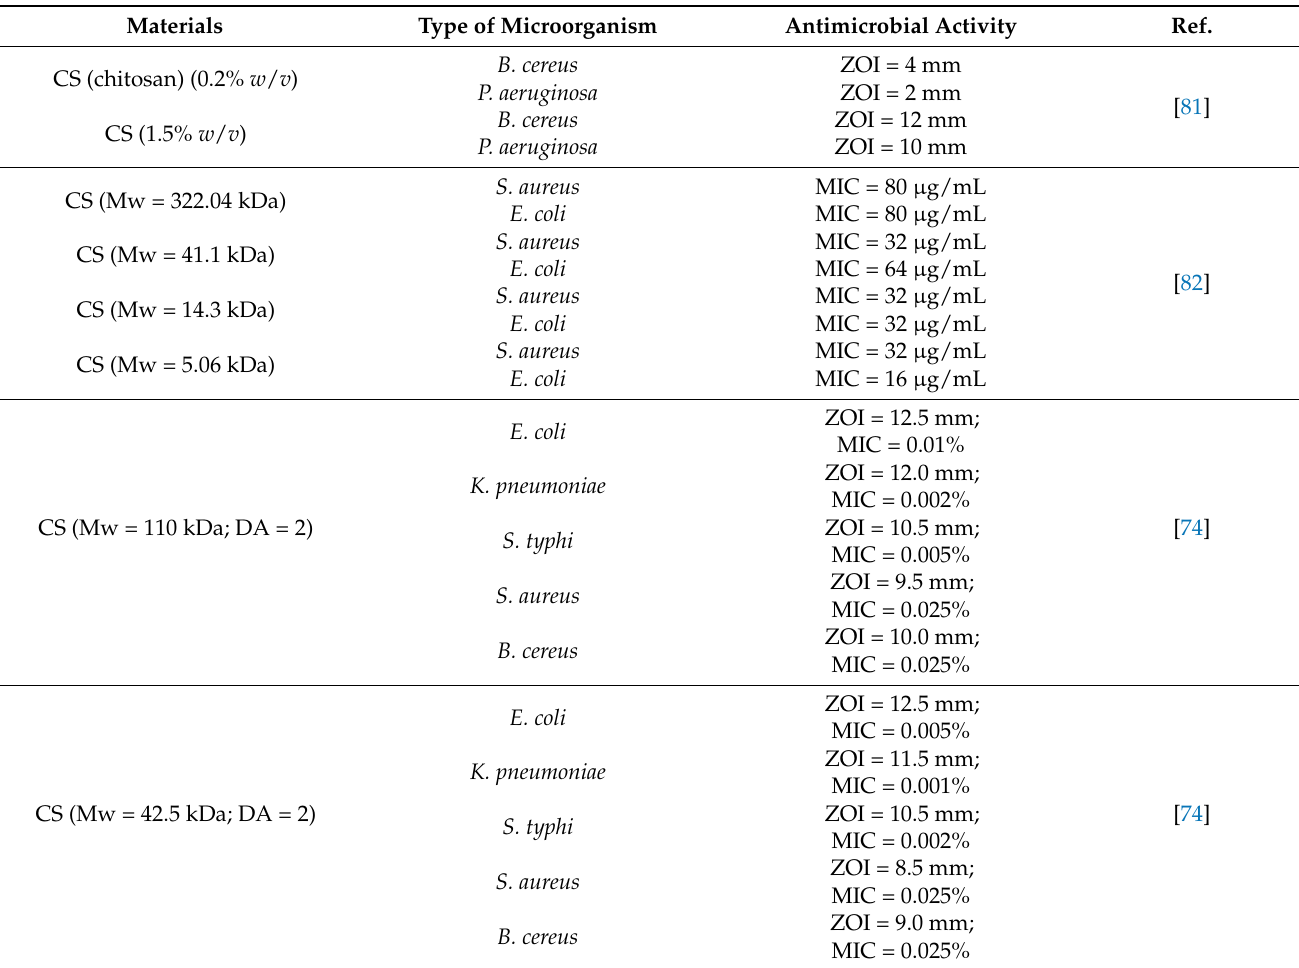
Table 1. The antimicrobial activity of chitosan and chitosan derivatives. Materials Type of Microorganism Antimicrobial Activity